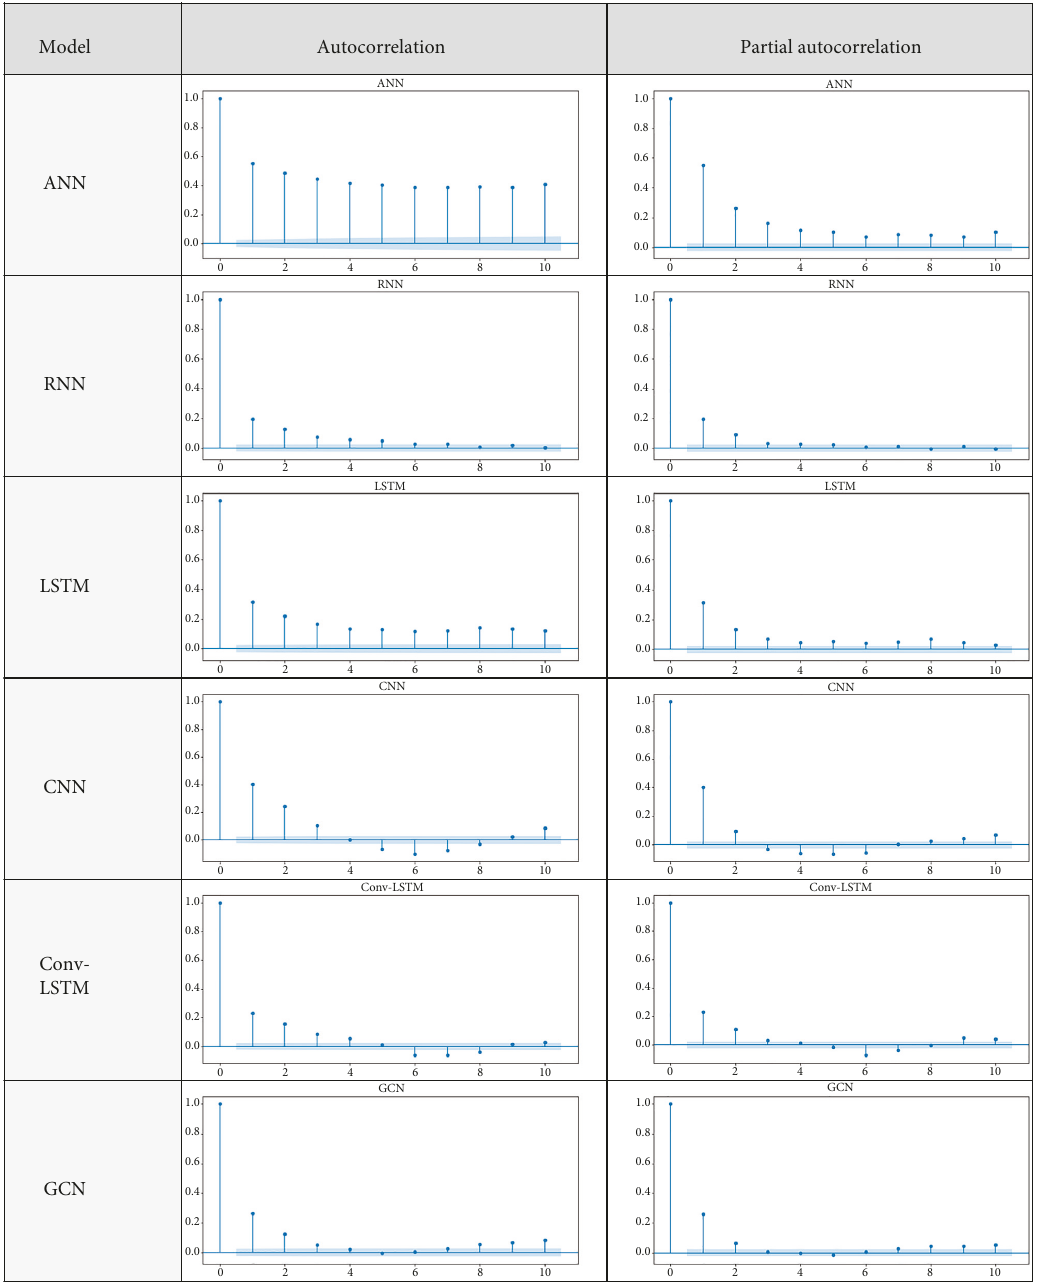
Figure 5: Autocorrelation and partial autocorrelation plot of global Moran’s